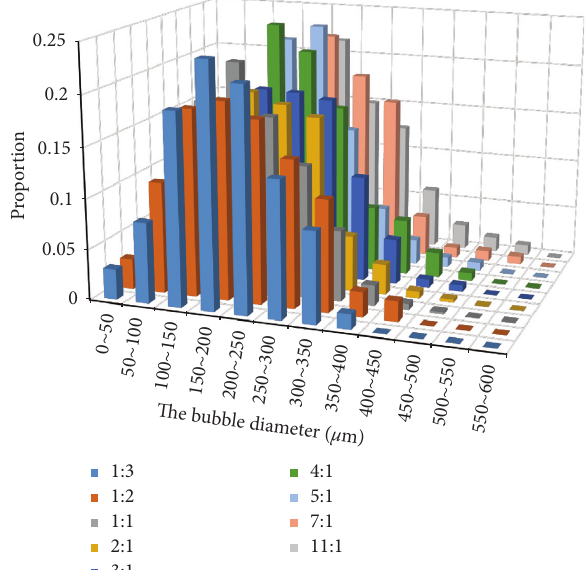
Figure 6: Particle size distribution of the foam under different surfactant mass